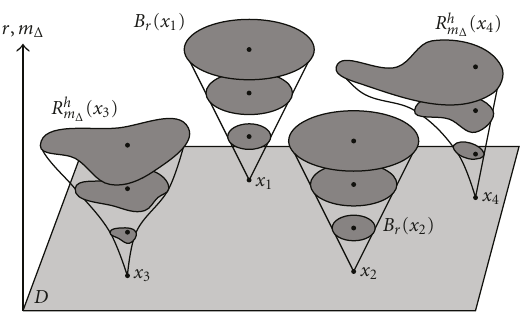
Figure 4: Representation of a logarithmic adaptive neighborhoods (LANs) structuring element R h